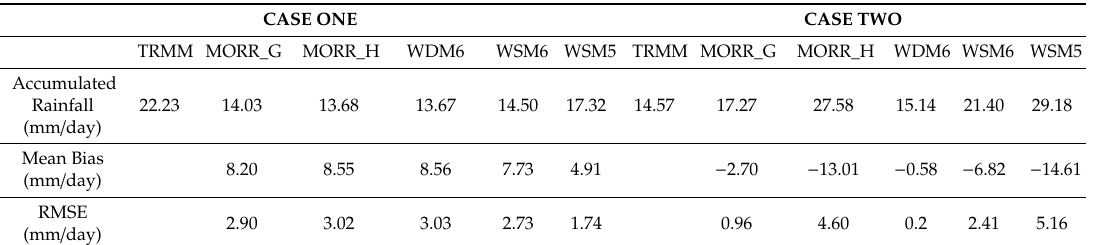
Table 2. Results of statistical metrics used to validate the model simulated accumulated rainfall with TRMM